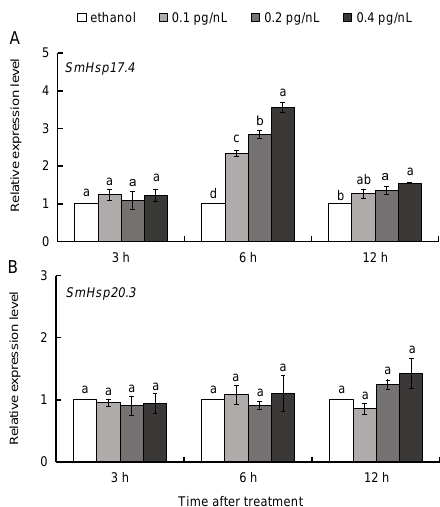
Figure 7. Effect of 20-hydroxyecdysone (20E) on expression of SmHsp17.4 ( A ) and SmHsp20.3 ( B ) in diapausing larvae collected in October. Transcript levels were determined by RT-qPCR at 3, 6, and 12 h after 20E (0–0.4 pg/nL) injection. Expression level of each treatment was relative to that of 50% ethanol injection (the control), which was arbitrarily set at 1. Bars represent the means ± SE. The different letters above the columns within each group indicated significant difference by Duncan’s multiple range test ( p < 0.05).